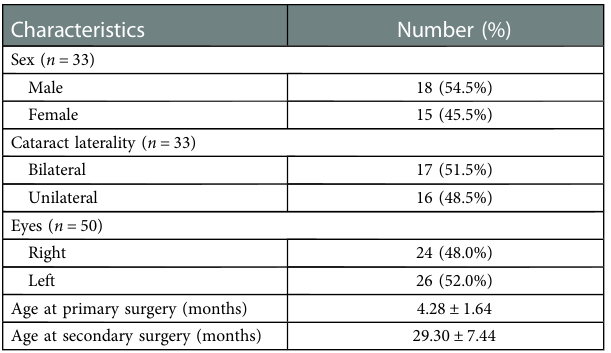
TABLE 1 Baseline data of the enrolled patients.